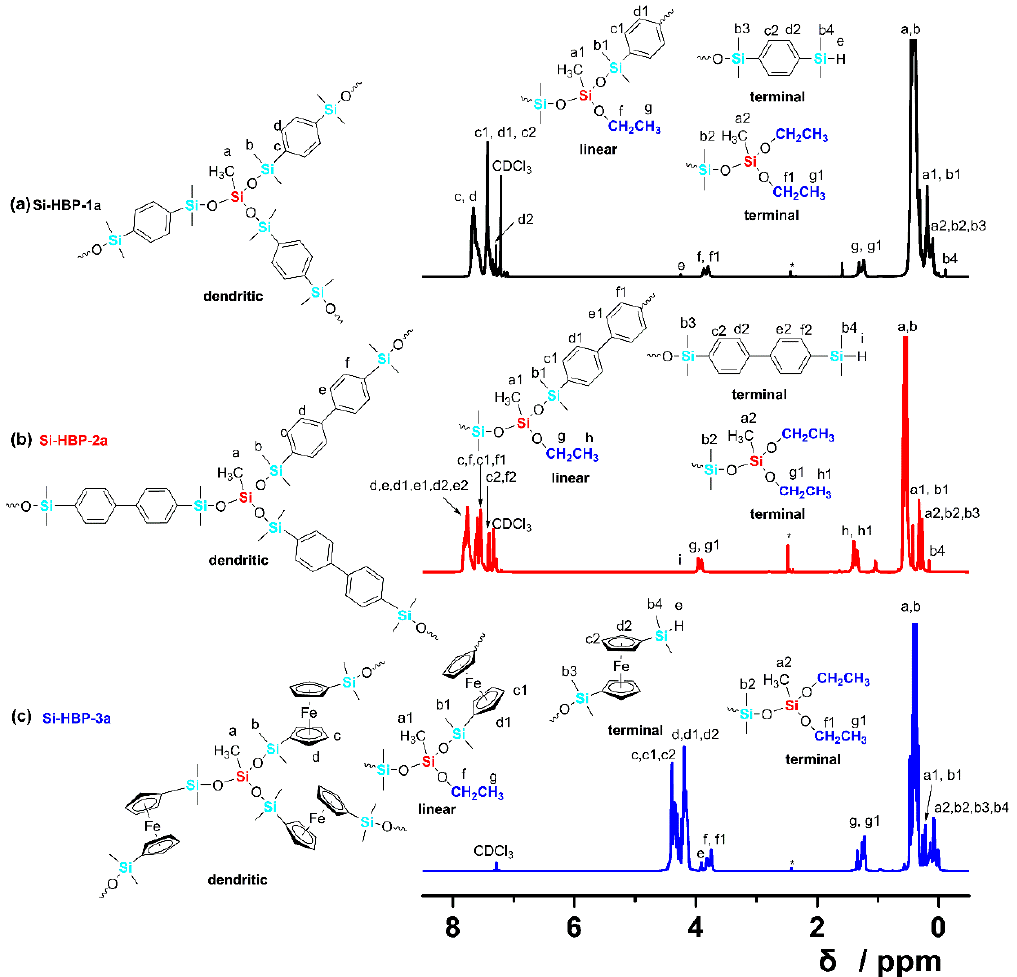
Figure 2. 1 H NMR spectra of Si-HBP-1a ( a ), Si-HBP-2a ( b ) and Si-HBP-3a ( c ). The asterisk denotes the residual toluene in the product.